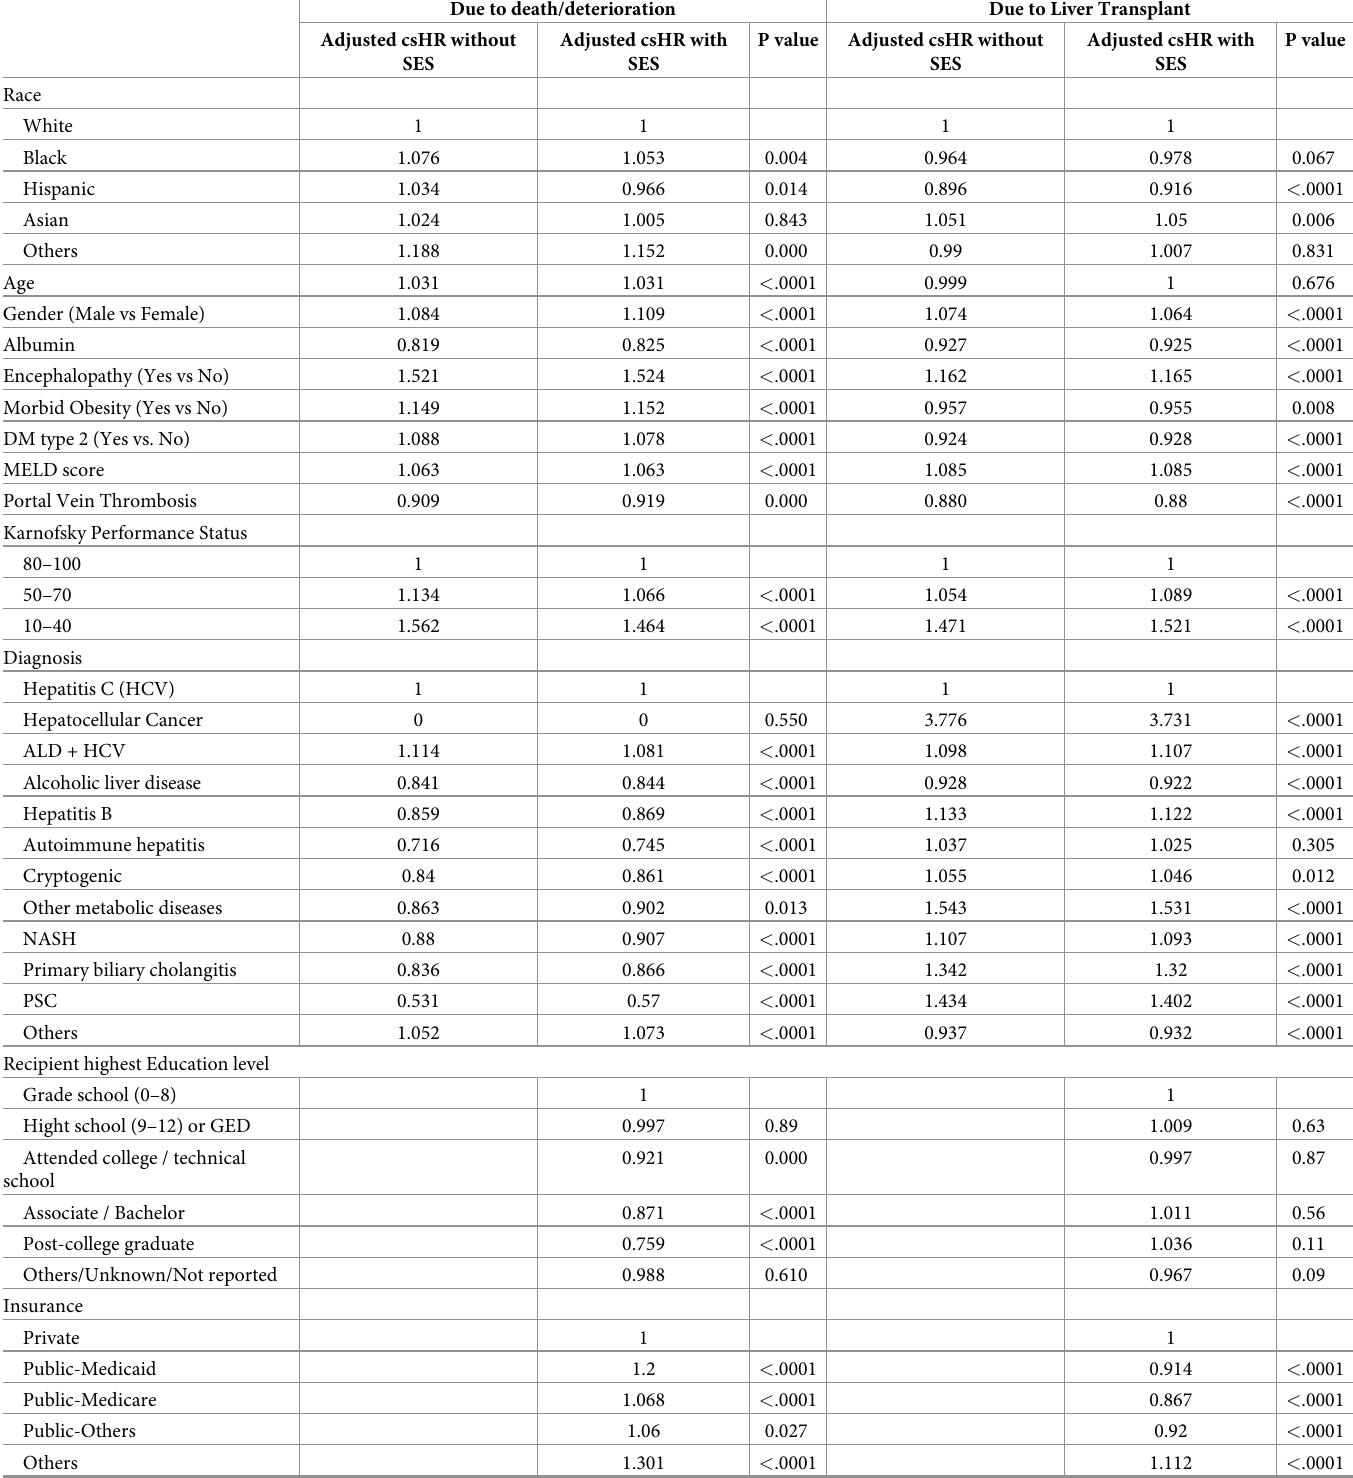
Table 2. Adjusted cause-specific Hazard Ratios (csHR) on removal due to death or deterioration and transplantation with and without socioeconomic status